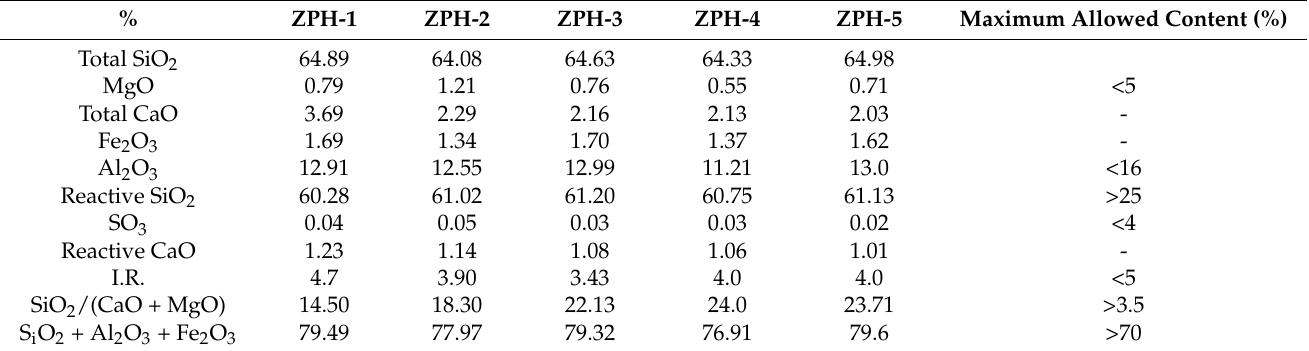
Table 2. Chemical characterisation to determine the pozzolanic quality of the mordenite–clinoptilolite.